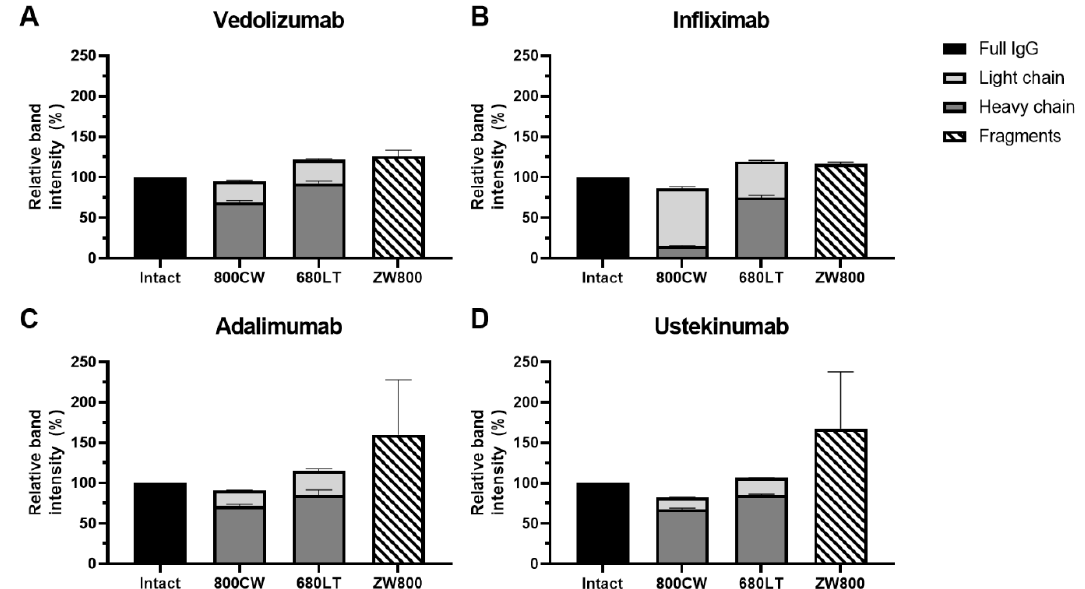
Figure 3. Fluorescent intensity sum of heavy and light protein chains compared to the intensity of the intact antibody (IgG), on sodium dodecyl sulfate polyacrylamide gel electrophoresis (SDS-PAGE). In all antibodies, the sum of mean fluorescent signals on heavy and light chains is comparable to full antibody when conjugated to 800CW (range: 82.0–95.4%) and 680LT (range: 106.6–121.5%). ZW800 conjugates do not show any relevant amounts of fluorescence on the reduced chains, instead a diffuse band at the fluid front of the gel can be seen that matches or exceed the fluorescence intensity of the intact IgG (125.7% ( A ), 116.5% ( B ), 159.8% ( C ) and 167.2% ( D )). A sum of the heavy and light chain fluorescence signal over 100% of the intact antibody suggests the occurrence of fluorescence quenching in the intact molecules. Data are displayed as the mean and standard error of mean of three measurements.